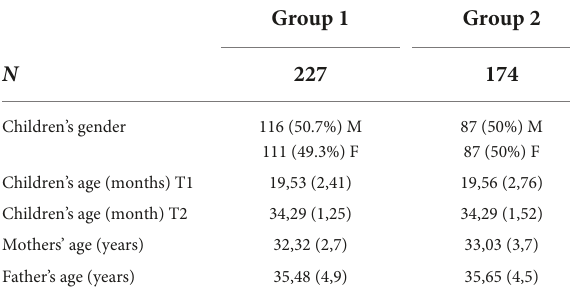
TABLE 1 Demographic characteristics of our